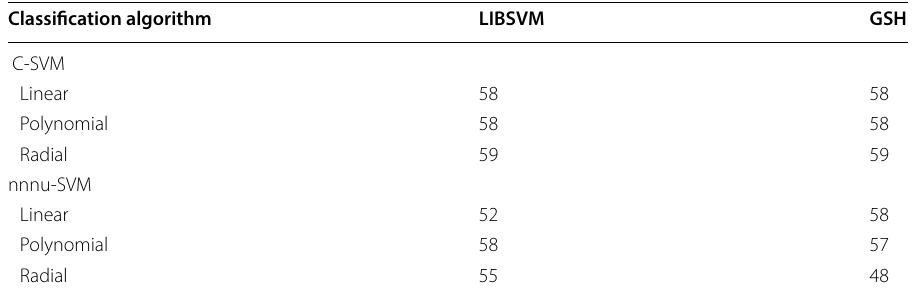
Table 10 Prediction accuracy (%) Classification algorithm